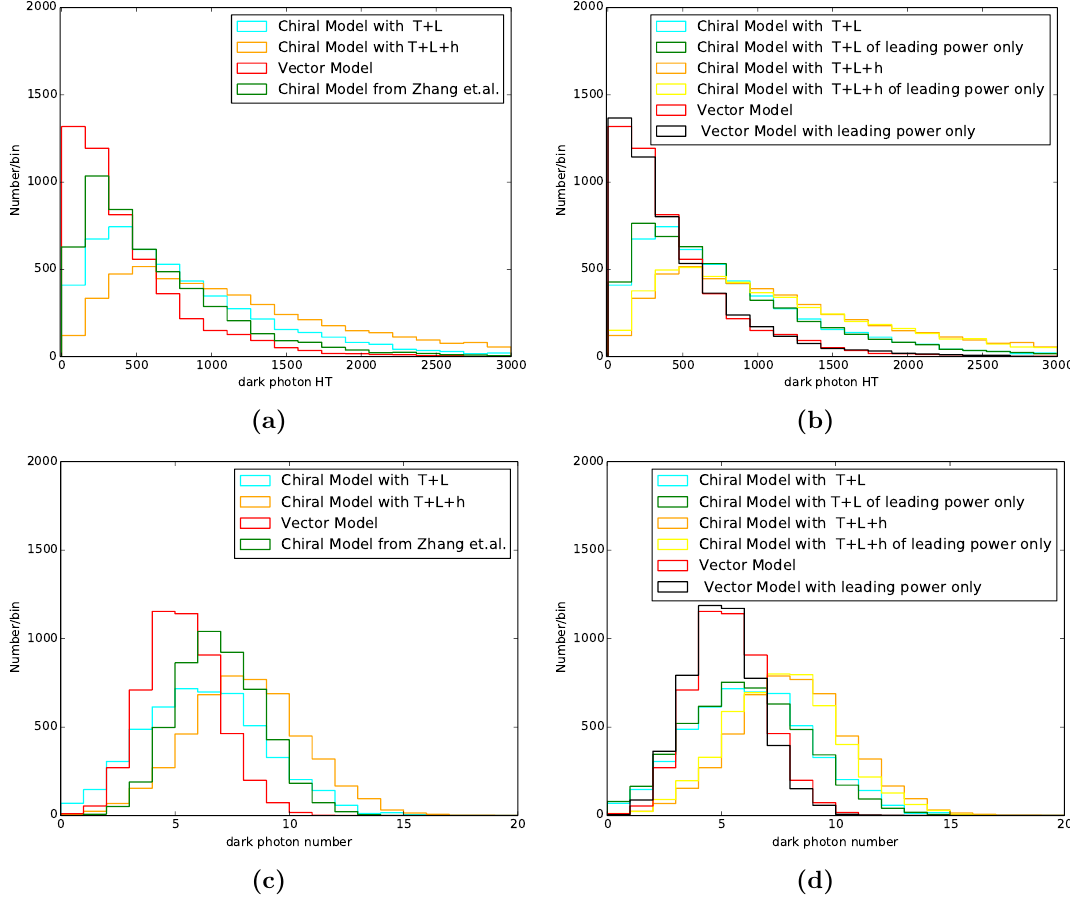
Figure 3 . Same as (cid:12)gure 2 but with Point B: (cid:11) 0 = 0 : 15, m (cid:31) = 1 : 0 GeV, m A 0 = 0 : 4 GeV, and m h 0 = 1 : 0